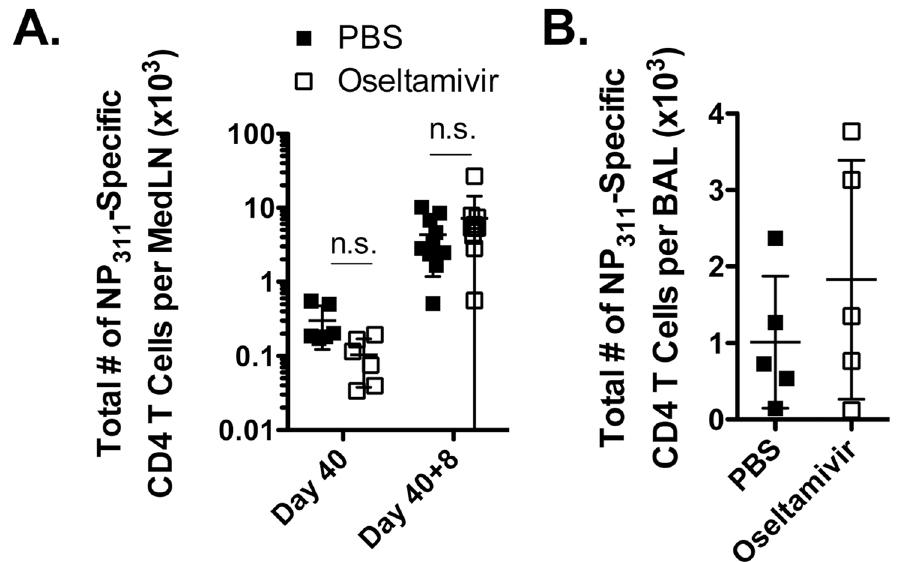
Fig 7. Normal influenza-specific CD4 + T cell responses in oseltamivir-treated mice after secondary infection. Mice were treated with PBS or oseltamivir and infected with influenza virus X31, then rested for 40 days. At this time point, mice were infected i.n. with 600 pfu of influenza PR8. At 8 days post-secondary infection, (A) MedLN and (B) BAL fluid were harvested and assessed for the total number of influenza IA b - NP 311 -specific CD4 + T cells by intracellular cytokine staining after ex vivo stimulation. These data represent 2 individual experiments with 4 – 5 mice per group. Error bars represent standard error of the mean. n.s., not significantly